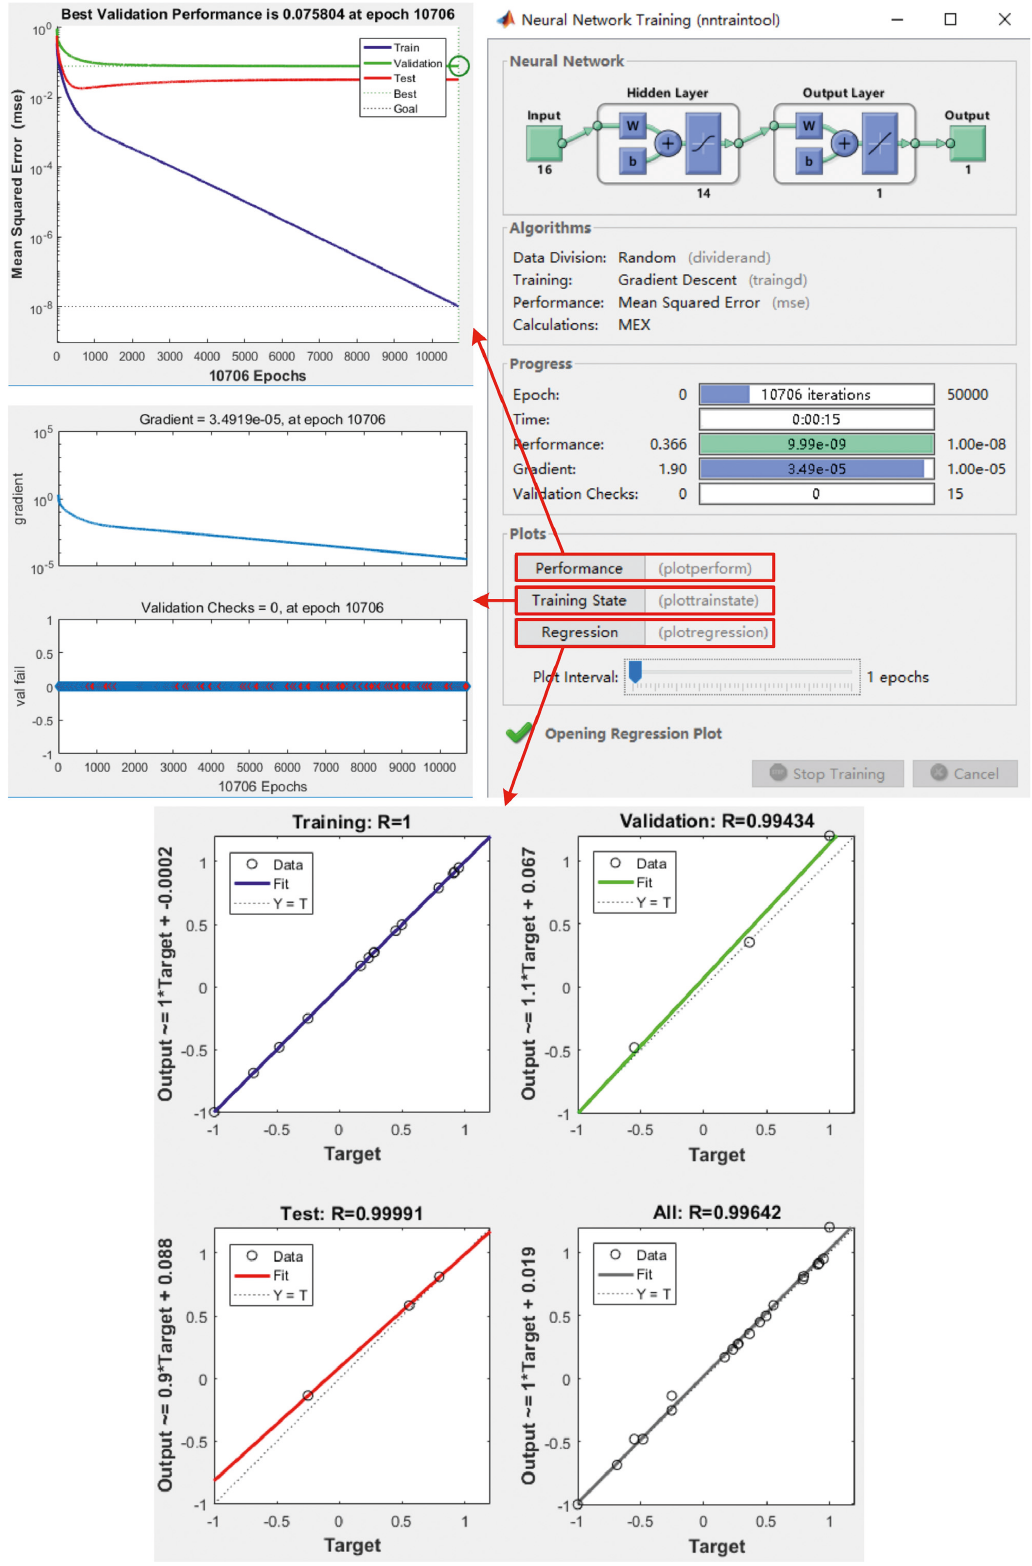
Figure 2: BP neural network